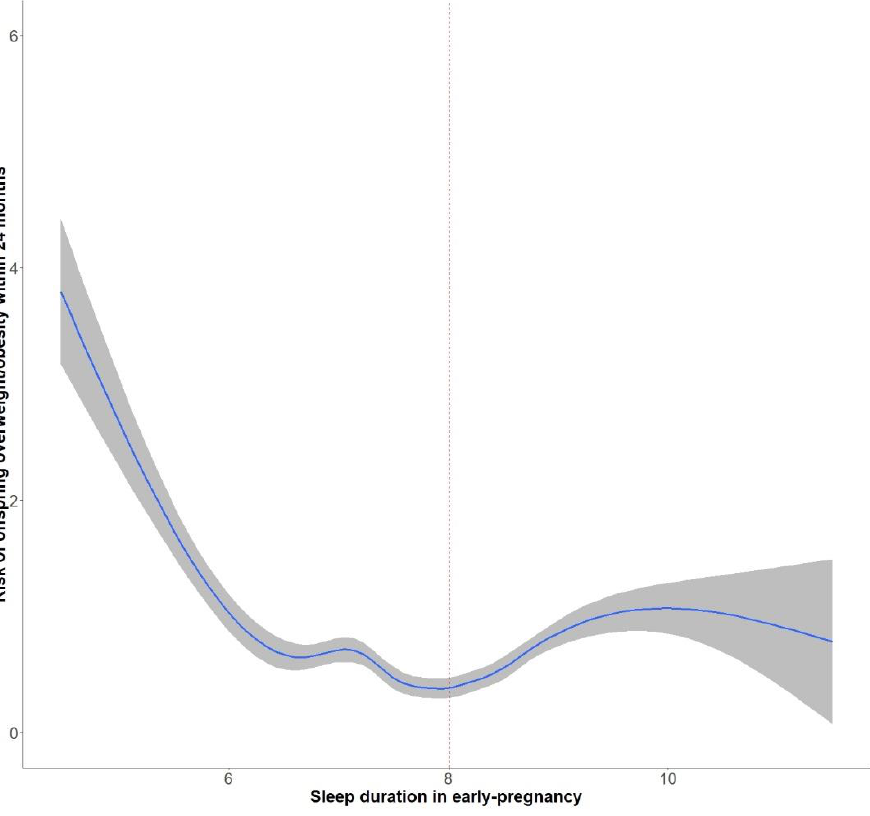
Figure 3. Association between maternal night − time sleep duration in early pregnancy and offspring growth in early life [OR (95% CI)]. Colored lines and shades around the line: OR with 95% CIs of effects of sleep duration in early pregnancy on offspring overweight/obesity within 24 months.